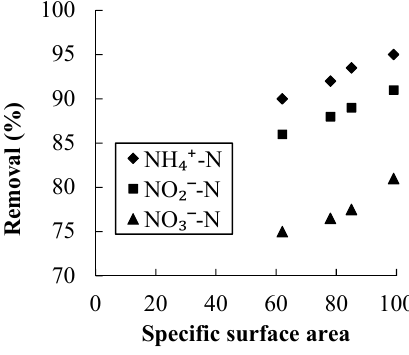
Figure 4. Effect of specific surface area on nitrogen removal.